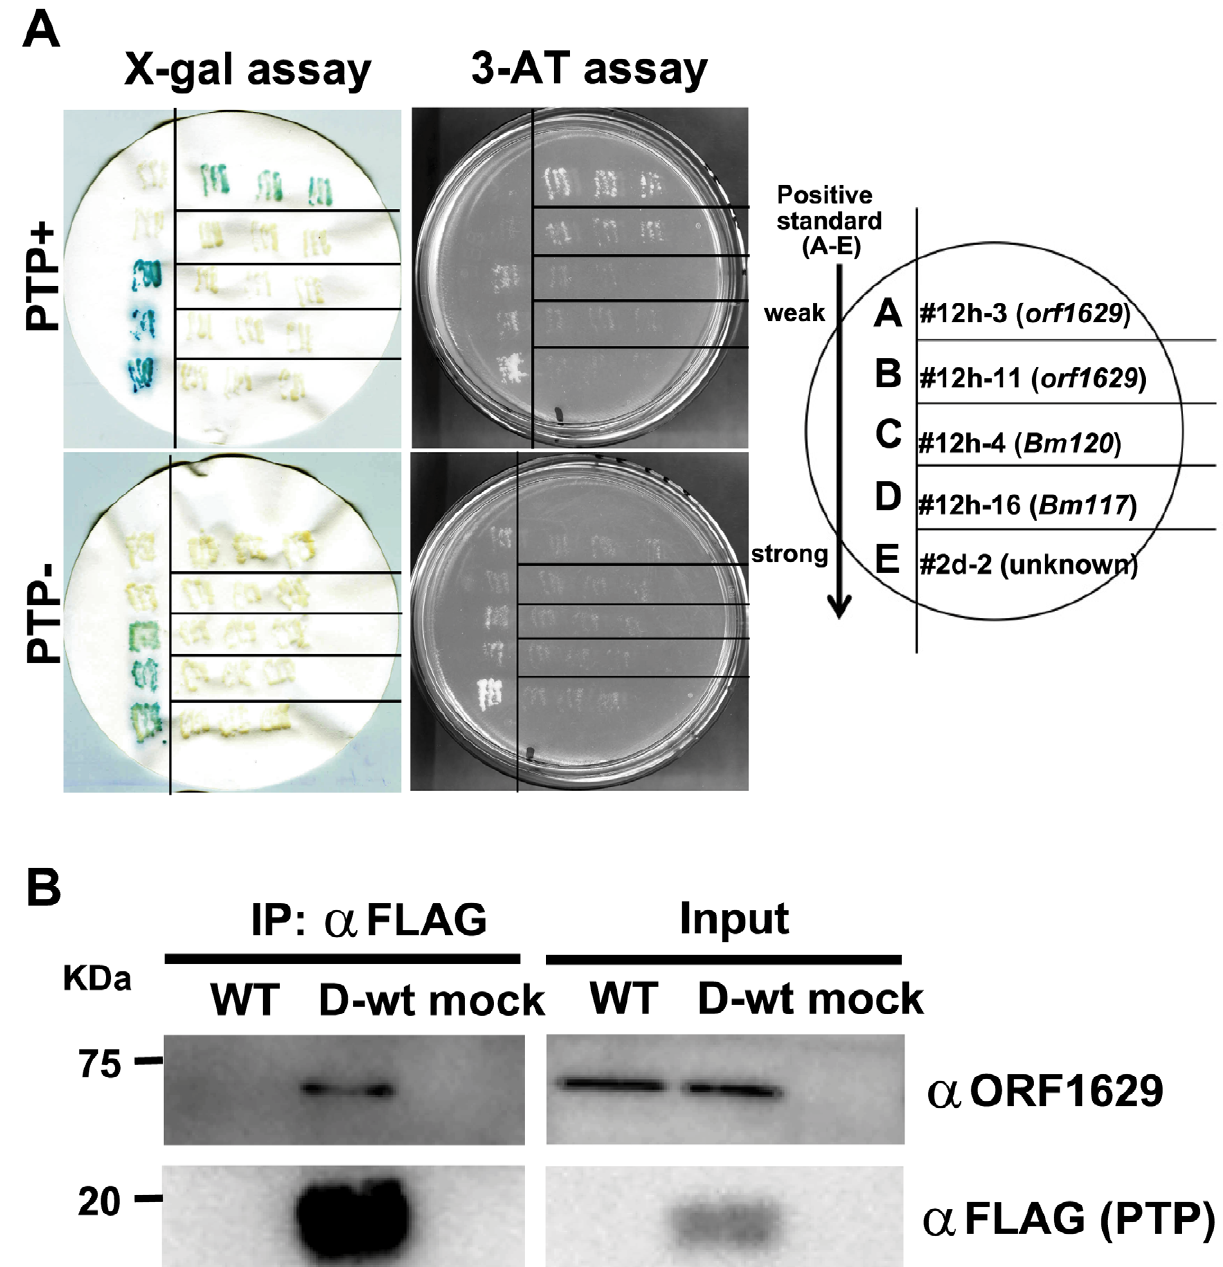
Figure 2. PTP interacts with ORF1629 in BmNPV-infected cells. (A) A yeast two-hybrid screen was performed to identify interactions between BmNPV PTP and proteins in BmNPV-infected (12 h p.i.) BmN cells or in epidermal tissues from BmNPV-infected (2 d p.i.) 5 th instar B. mori . This screening identified 5 PTP-interacting clones (12h-3, 12h-11, 12h-4, 12h-16, and 2d-2) by X-gal and 3-AT assays. Clones 12h-3, 12h-11, 12h-4, and 12h- 16 were derived from BmNPV-infected BmN cells whereas clone 2d-2 was derived from BmNPV-infected larval B. mori . A legend showing the location of positive standards and PTP-interacting clones (streaked in triplicate) is shown to the right. (B) Interaction of PTP and ORF1629 in BmNPV-infected BmN cells. BmN cells were inoculated with BmNPV (WT) or BmPTPD-wt (D-wt) at an MOI of 5 or mock-infected (mock). BmPTPD-wt expresses FLAG- tagged PTP under an authentic ptp promoter. At 72 h p.i., the cells were harvested and immunoprecipitated with anti-FLAG antibody, and then subjected to western blot analysis (left panels) with anti-ORF1629 antibody or anti-FLAG antibody. The right ‘‘Input’’ panels show western blot analysis using whole cell extracts. doi:10.1371/journal.ppat.1002644.g002 of hemocytes to virus-infected tissues. vFGF is thus able to usurp ( vfgf ) gene is a clear example of a captured ancestral host gene whose authentic function has been maintained during evolution the host’s signaling pathway in order to recruit hemocytes which, [20,21]. The protein encoded by vfgf , vFGF, transmits its signaling following infection, can disseminate the virus to other tissues and via a host FGF receptor that, when activated, causes the migration increase systemic infection. BmNPV ptp is another example of a